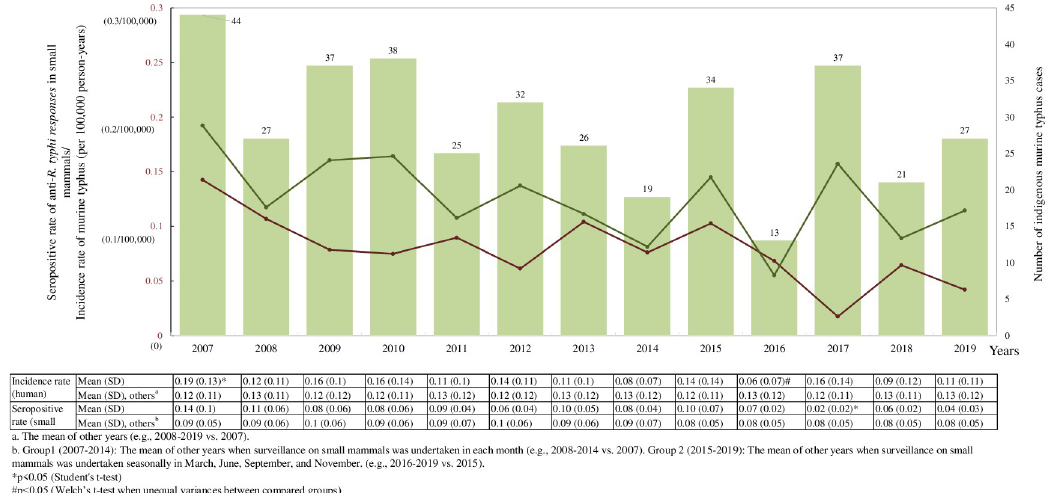
Fig 3. Yearly seropositive rate of anti- R . typhi responses in small mammals and incidence rate of indigenous murine typhus in humans from 2007–2019. The seropositive rate and incidence rate (per 100,000 person-years) are shown as brown and green curves, respectively. The numbers of indigenous murine typhus cases are shown as green bars. The correlation between the incidence rate of indigenous human cases/seropositive rates in small mammals and years is presented in the table below.